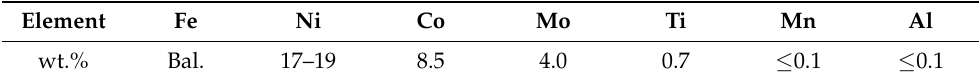
Table 1. Chemical composition of 18Ni-300 maraging steel powder.